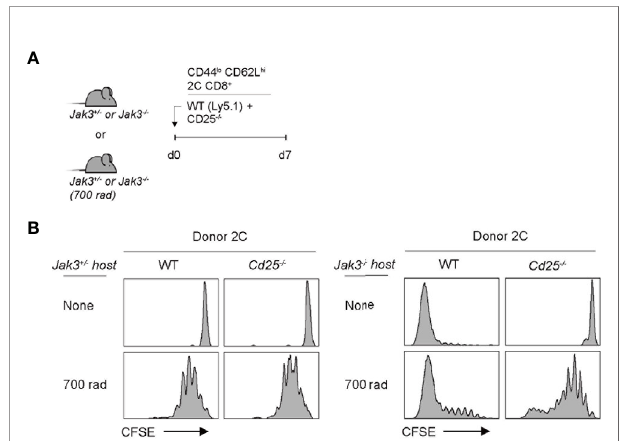
FIGURE 3 | Role of IL-2R a expression for inducing donor T cell expansion in Jak3 − / − hosts. (A) Schematic diagram for adoptive transfer experiments. A mixture of FACS-puri fi ed CFSE-labeled naive WT (Ly5.1) and CD25(IL-2R a )- de fi cient 2C CD8 + T cells was co-injected i.v. into either irradiated (700 rad) or unmanipulated Jak3 − / − and as a control Jak3 +/ − mice (0.5 × 10 6 cells for each donor per mouse; n = 2 – 3 mice). (B) Spleen cells of the recipient mice were analyzed on day 7 for CFSE dilution by fl ow cytometry.